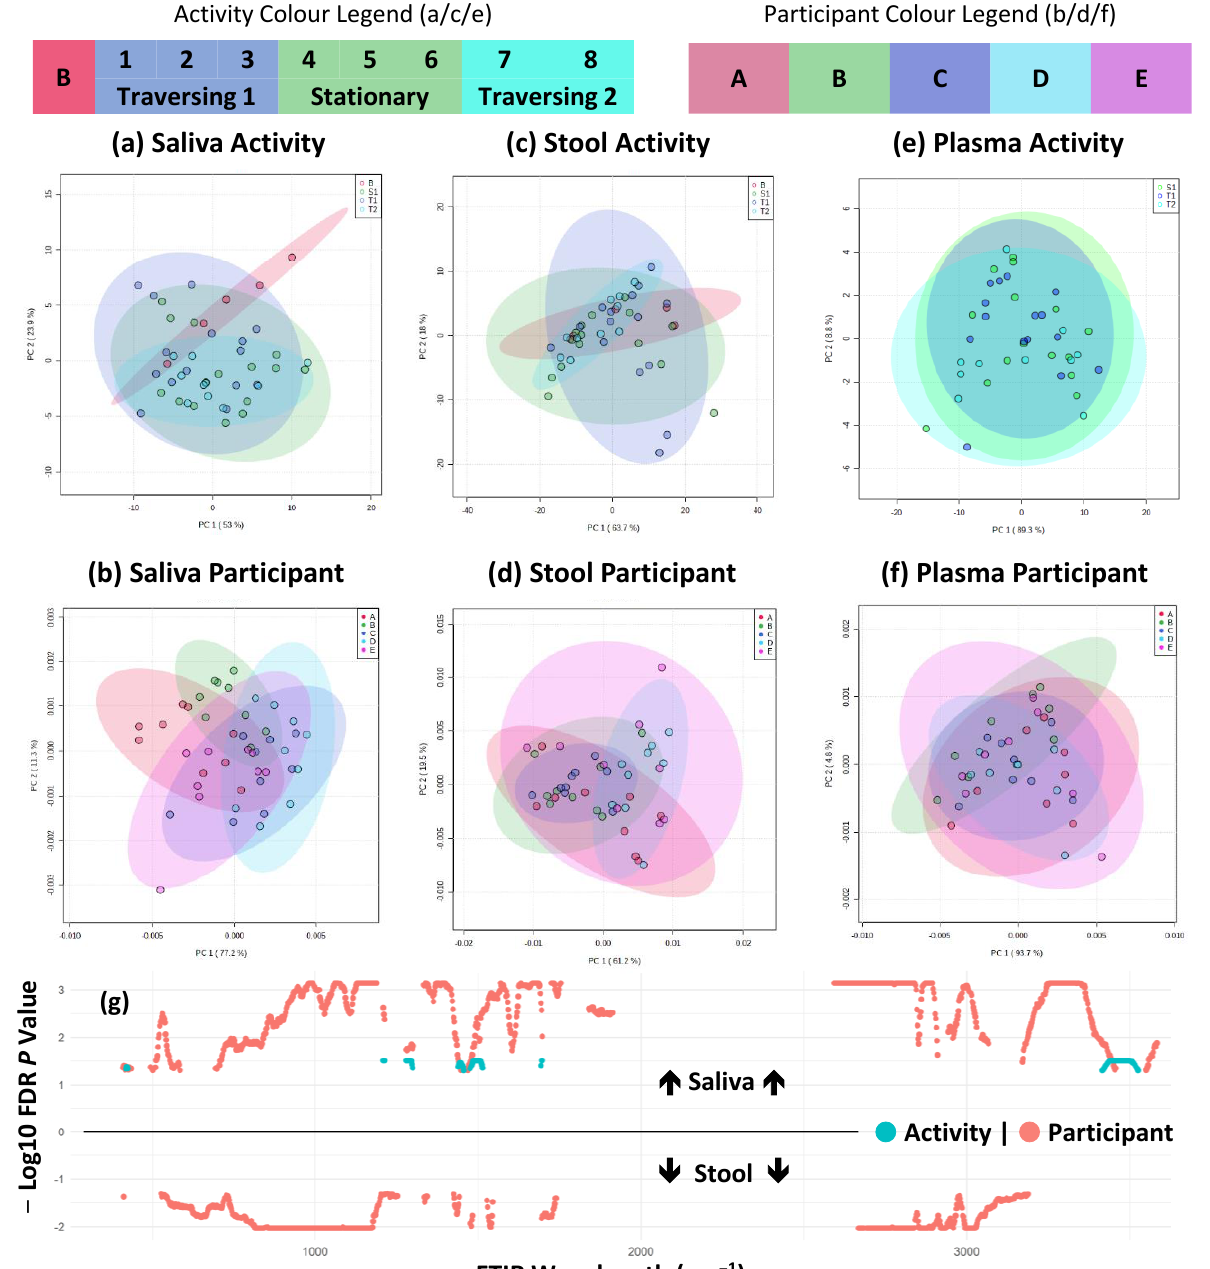
Figure 4. FTIR fingerprinting shows maintenance of individual difference but minor activity effects. ( a – f ) PCA plots of first two components across sample types and activity/participant differences; ( g ) shows significantly different (FDR corrected p < 0.05) FTIR fingerprint wavelengths across saliva (above line) and stool (below line) and activity/participant differences as indicated by colour shading and plotted from 400 to 4000 cm −1 wavelength range. No significantly different features were detected in plasma samples.